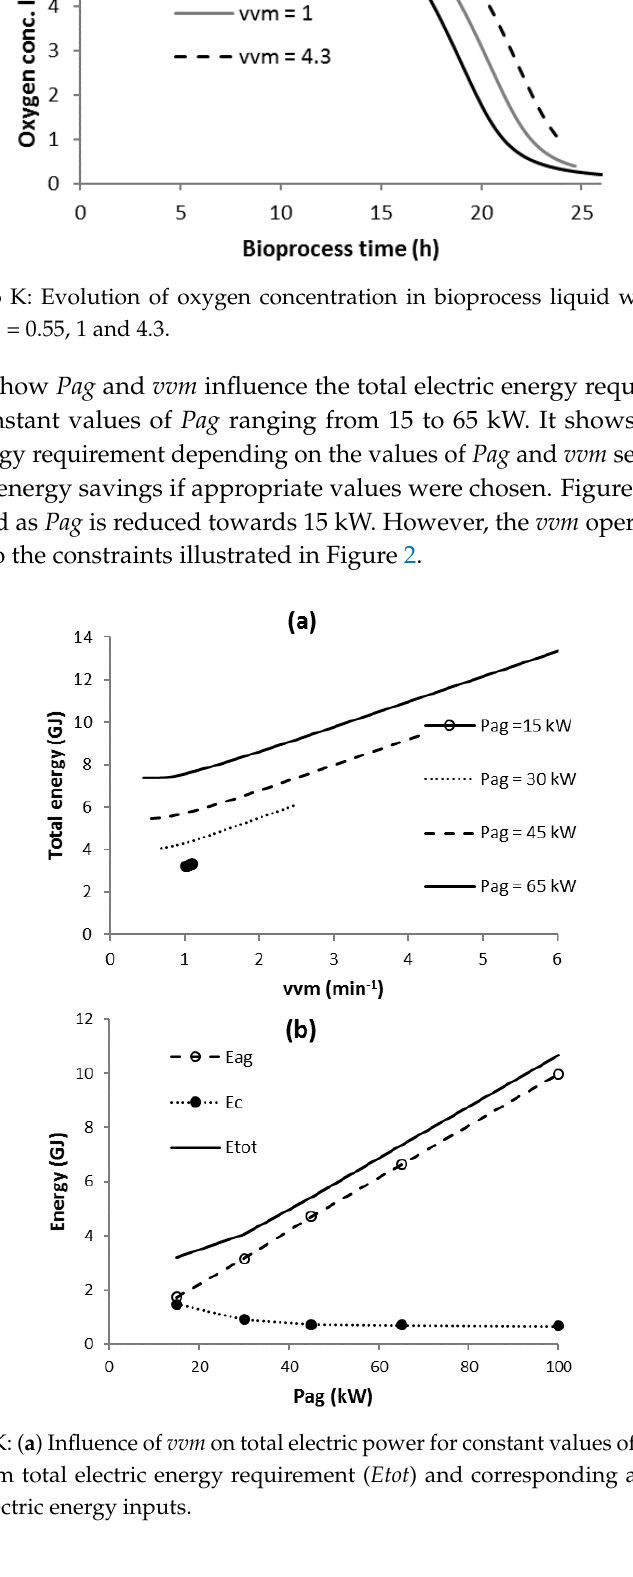
Figure 3. Scenario K: Influence of vvm on agitator ( Eag ), compressor ( Ec ) and total ( Etot ) electric energies and bioprocess time for Pag = 45 kW.